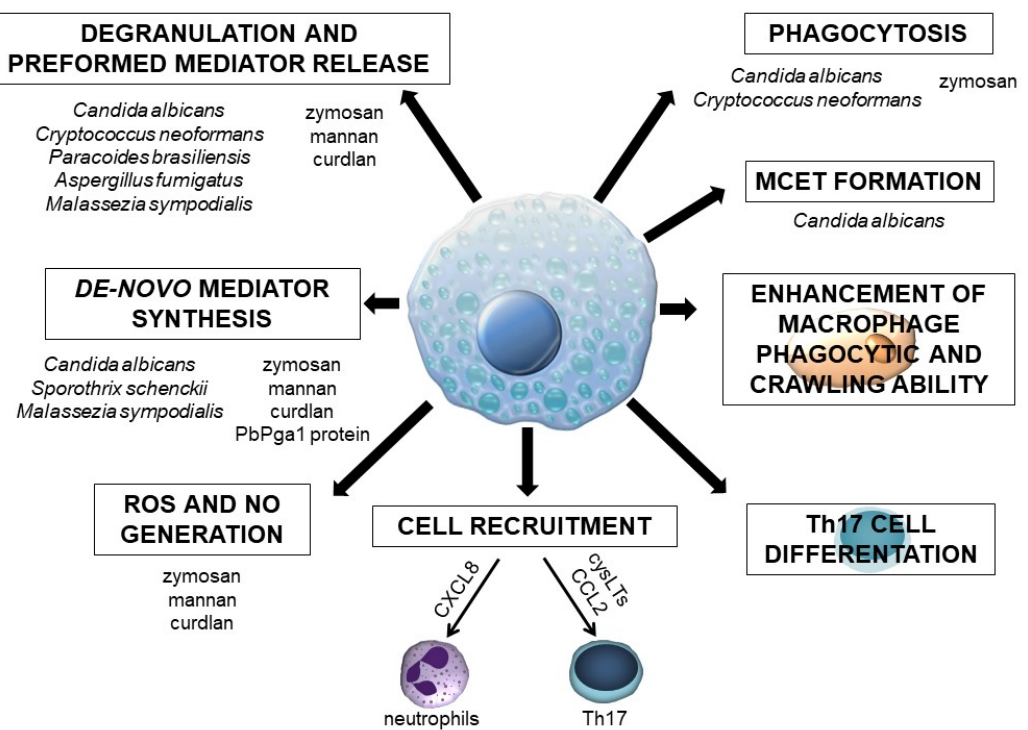
Figure 3. MC activities in response to fungi or fungus-derived molecules.